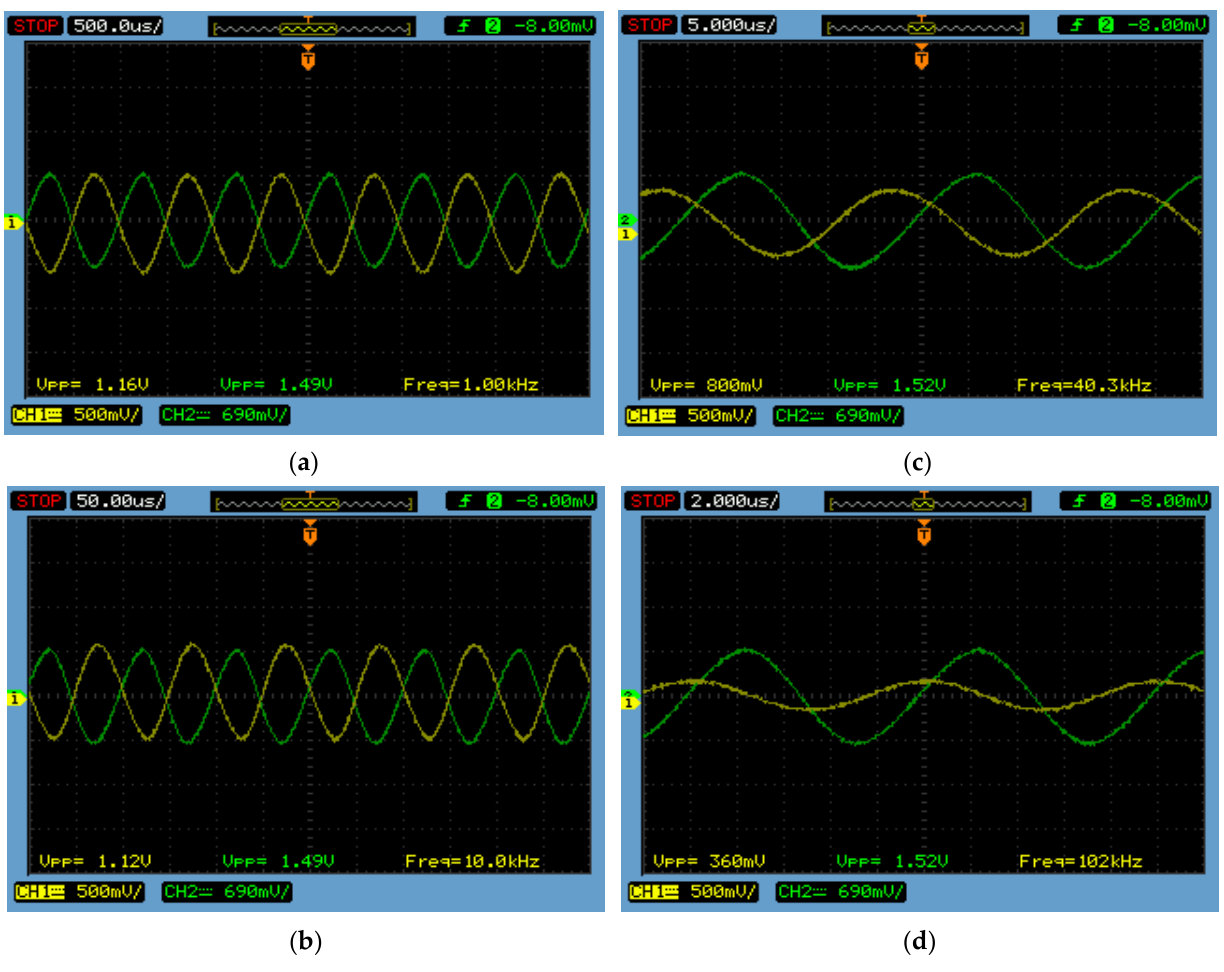
Figure 13. Experimental results of the LP filter showing input and output waveforms at ( a ) 1 kHz, ( b ) 10 kHz, ( c ) 40 kHz and ( d ) 100 kHz.